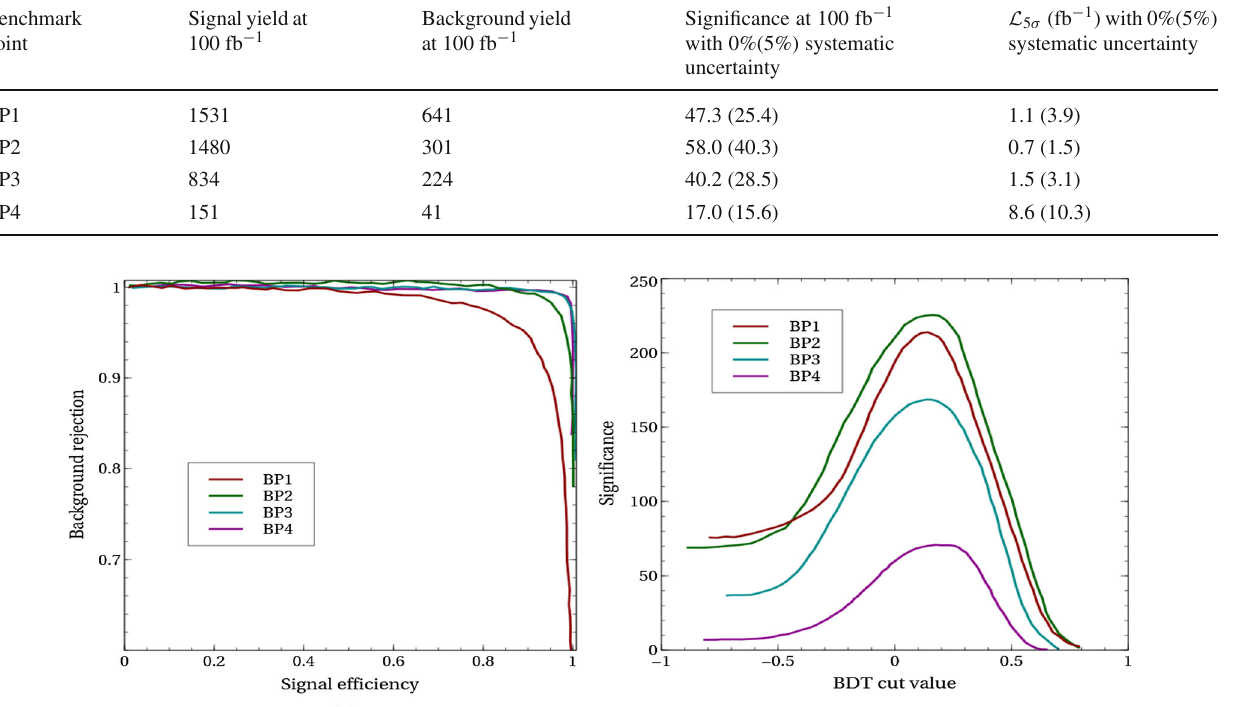
( a ) (b) , (cid:12) R (cid:10) Fig. 4 Normalized distributions of (cid:12) R (cid:10) for 1 (cid:10) + 2 j + E / T channel at 1 TeV ILC 1 j 1 1 j 2 Table 12 The signal and background yields at 1 TeV ILC with 100 fb − 1 integrated luminosity for BP1,BP2, BP3 and BP4 along with luminosity required for 5 σ significance for the e + e − → 1 (cid:10) + 2 j + E / T channel after performing the BDTD analysis